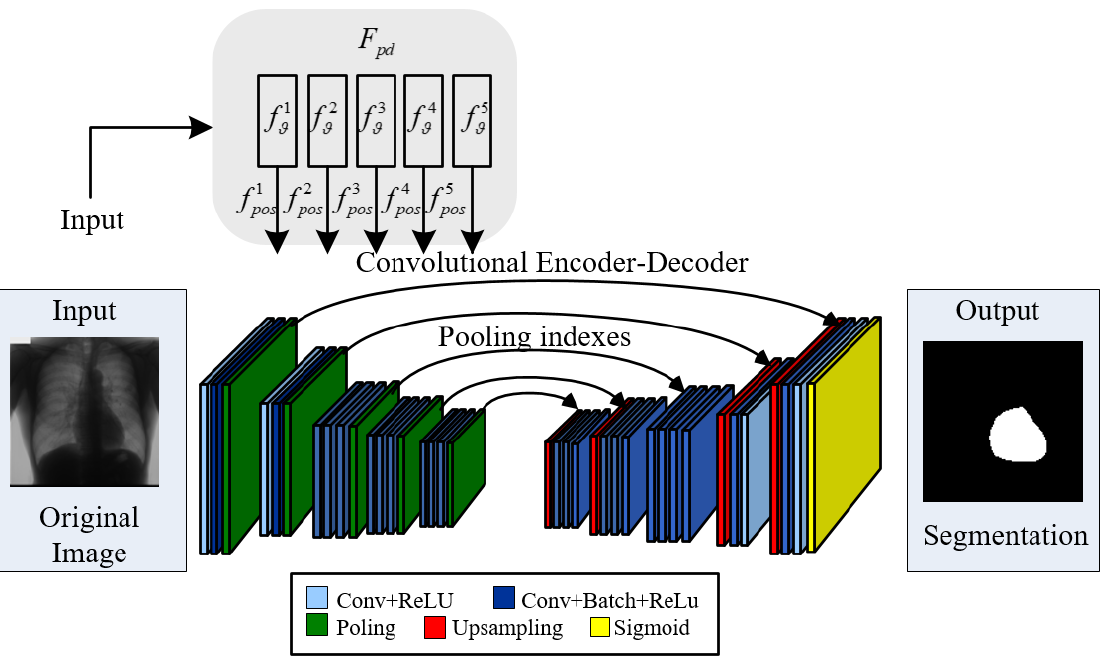
Figure 6. PDNet network framework.